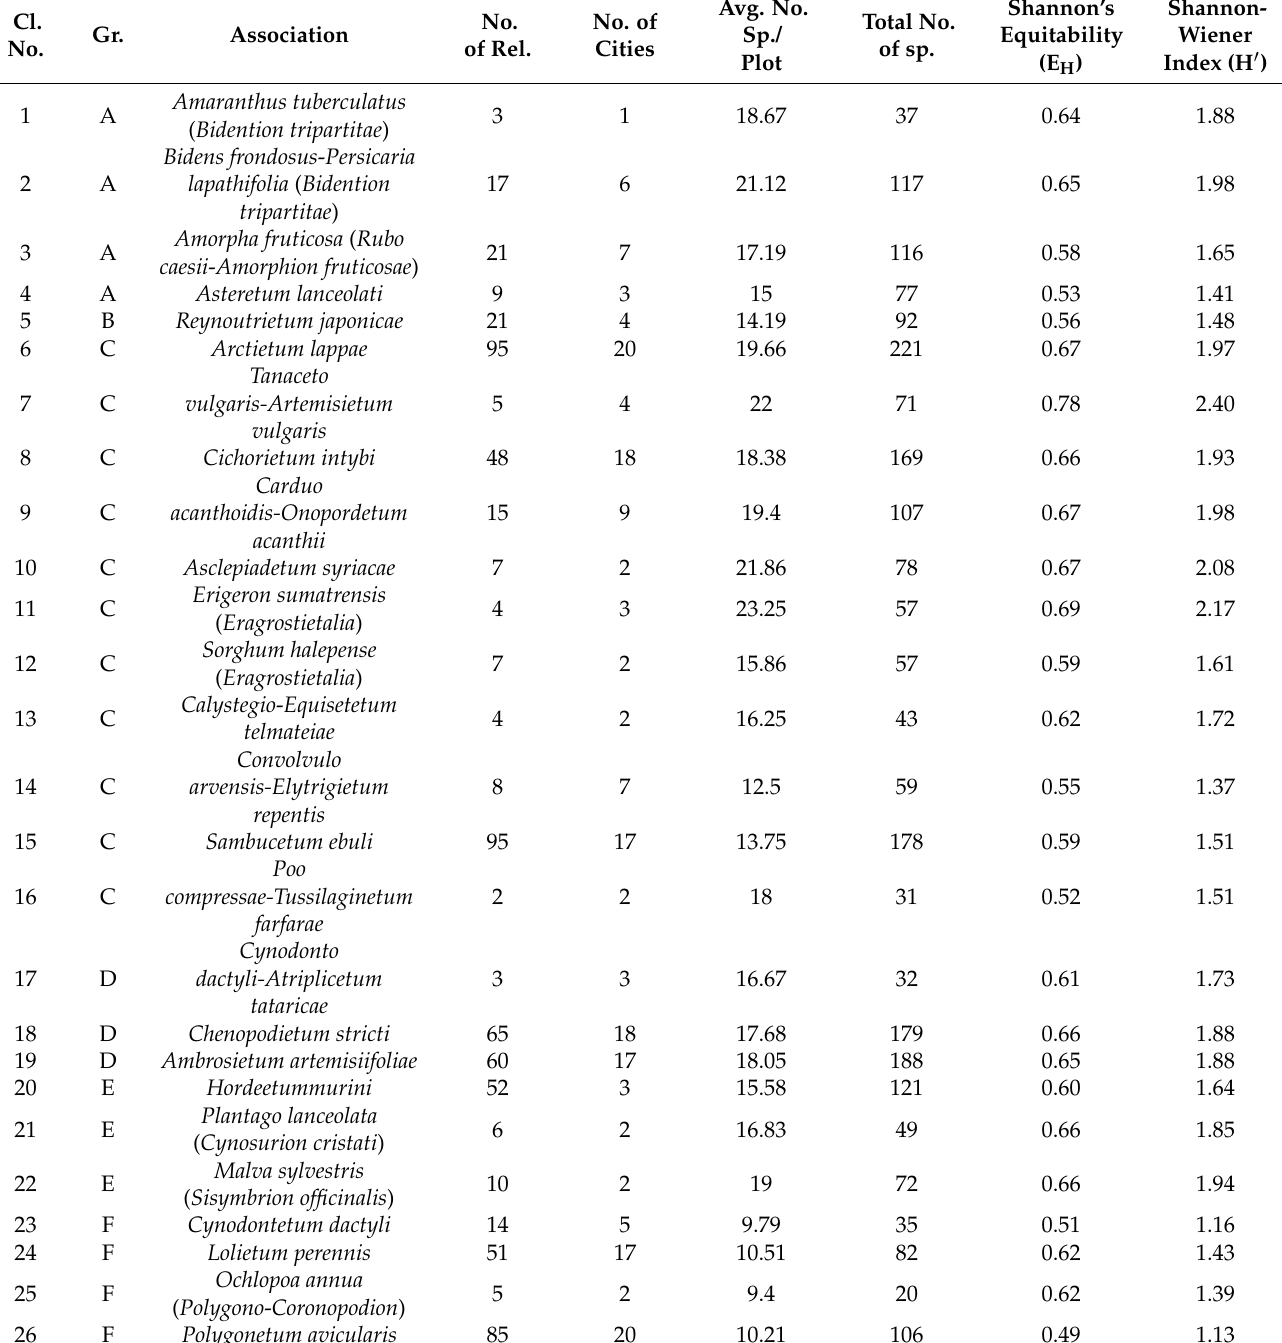
Table 1. Floristic parameters of ruderal